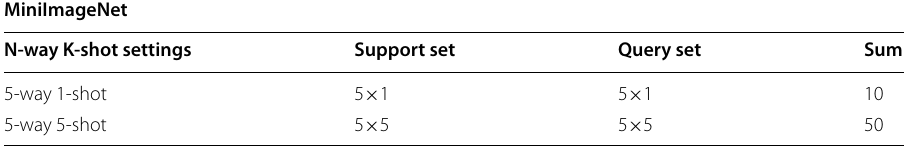
Table 1 MiniImageNet experiment settings MiniImageNet